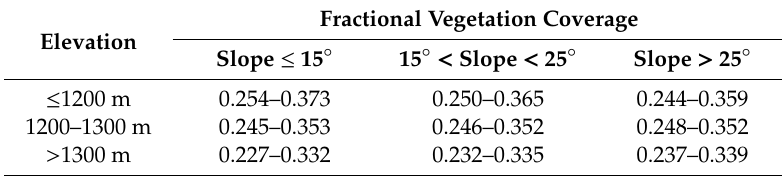
Table 1. Fractional vegetation coverage in sunny slope of soil-covered Pisha Sandstone